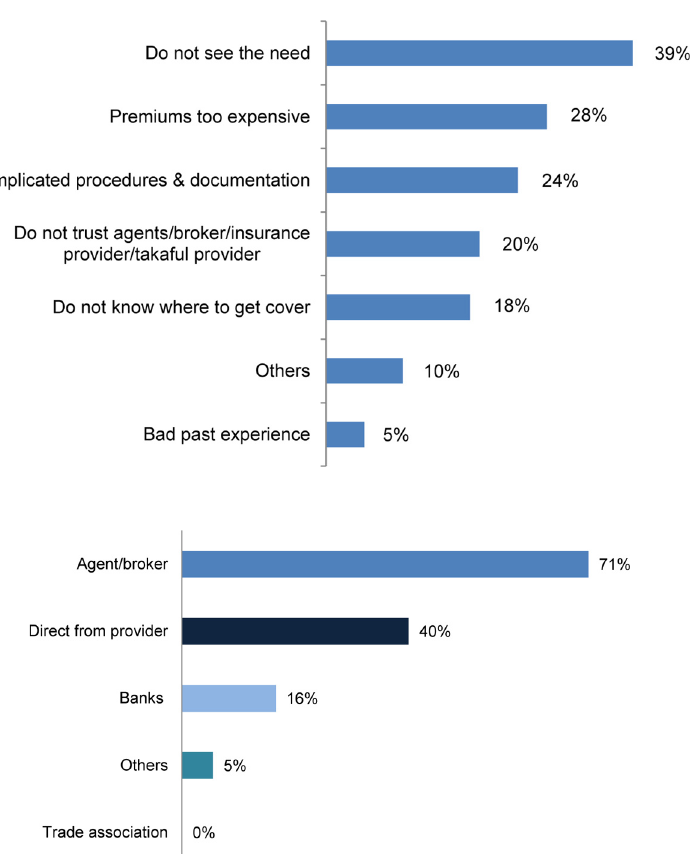
Figure 17. Channels used